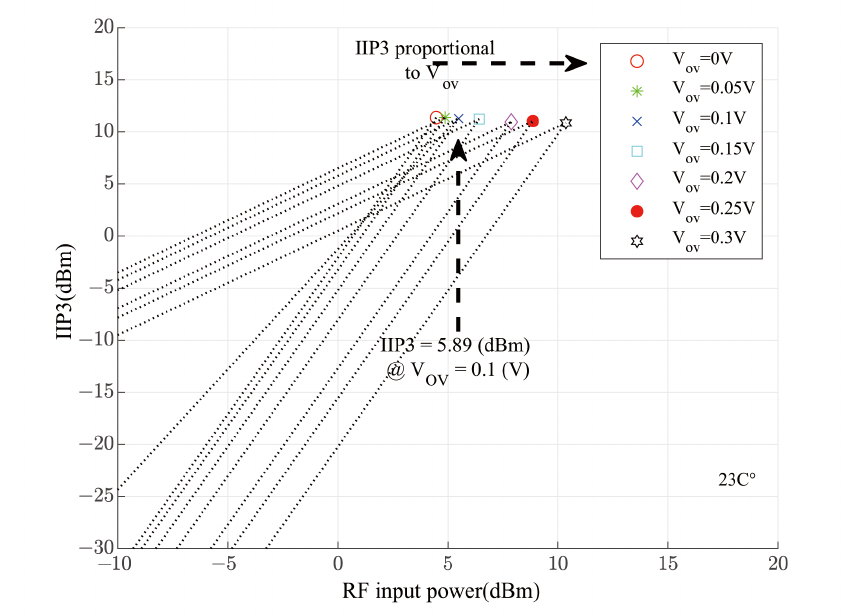
Figure 5. Noise Figure vs. frequency.